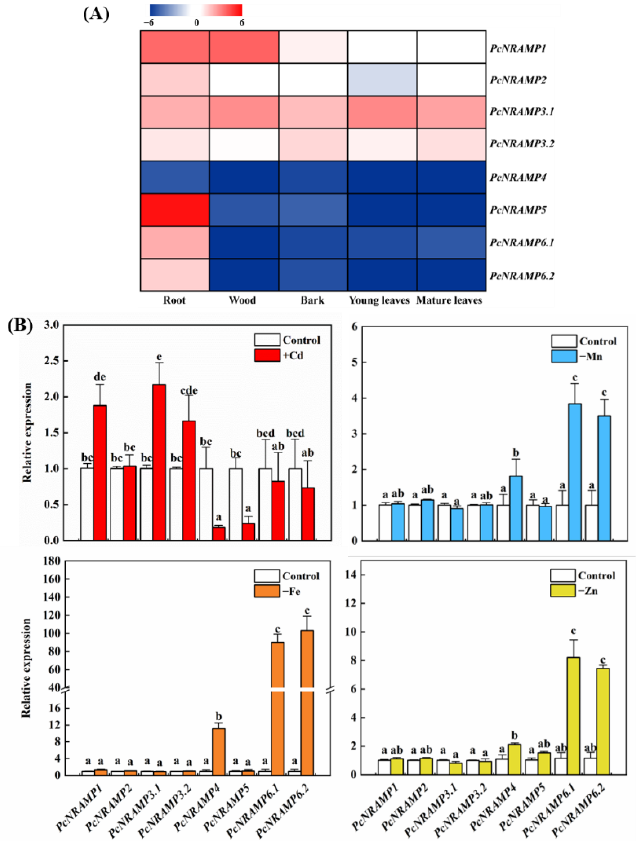
Figure 2. The expression profiles of PcNRAMP genes. The expression levels of PcNRAMP genes in different tissues without Cd exposure ( A ) and in the roots ( B ) of P . × canescens supplied with one-fourth Hoagland solution in combination with either 0 ( − Cd) or 100 (+Cd) µ M CdCl 2 , and the deficiency in one of Mn ( − Mn), Fe ( − Fe) and Zn ( − Zn) for 7 days. Bars indicate means ± SE (n = 4). Different letters on the bars indicate significant differences in the relative expression levels among different PcNRAMP genes. In panel ( A ), the expression level of each PcNRAMP in different tissues was compared with the median of all genes, and the fold change in the expression level of each PcNRAMP was calculated based on the log2 value of its expression level. In panel ( B ), for each gene, the expression level was set to 1 in the roots of control plants, and the corresponding fold changes were calculated under other